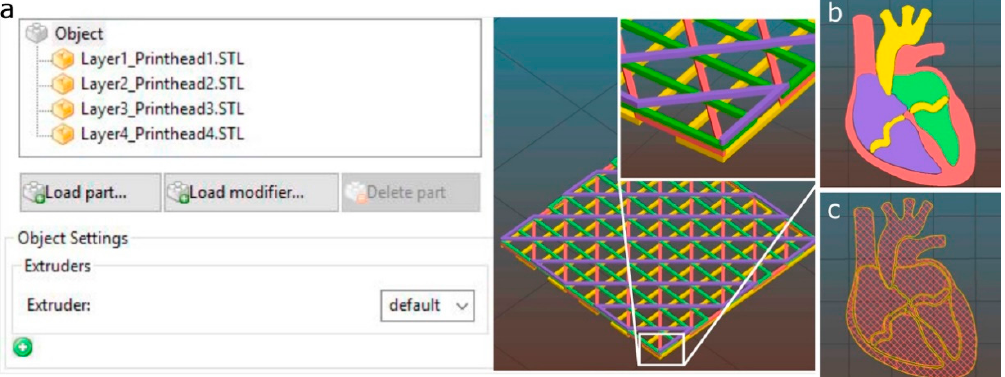
Figure 3. Flowchart of the procedure for the G-code generation and the interaction with the 3D bioprinter interface.